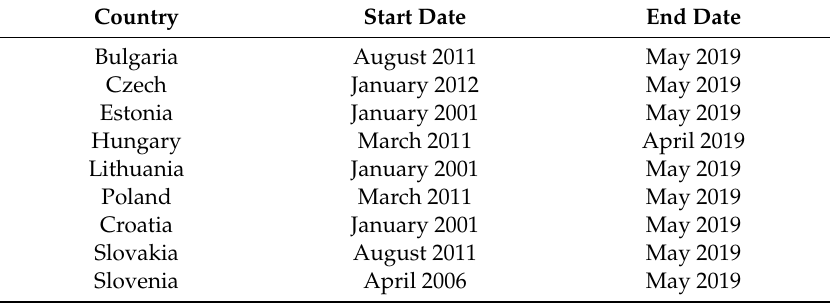
Table A1. Time span used for every country.